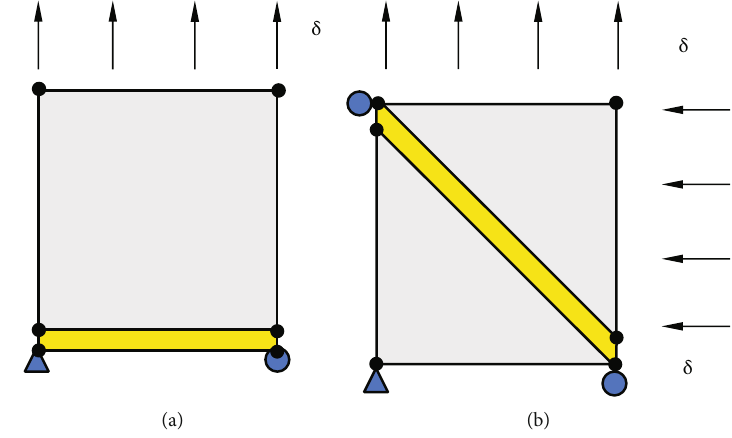
Figure 7: Pure mode I and pure mode II test.